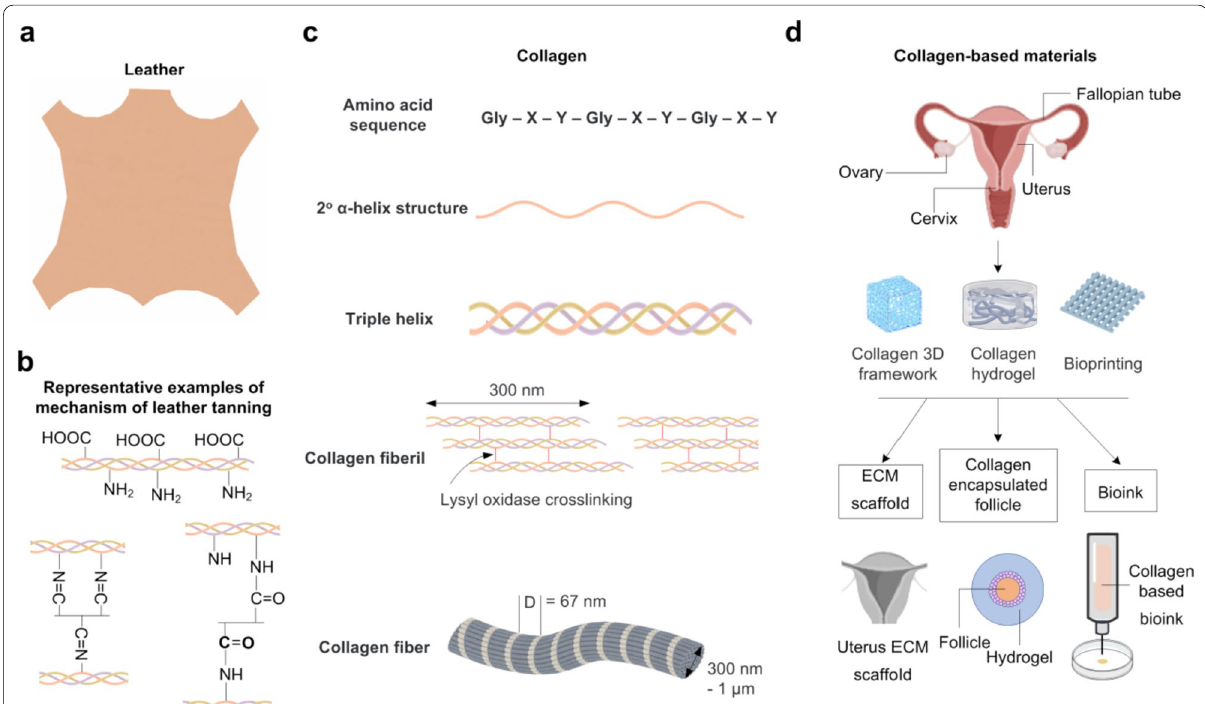
Fig. 1 a , b Illustration of leather and representative examples of leather tanning mechanisms. c Schematic drawing of the hierarchical structures of collagen [19]. Reproduced with permission from [19]. d Collagen-based materials and their use in reproductive